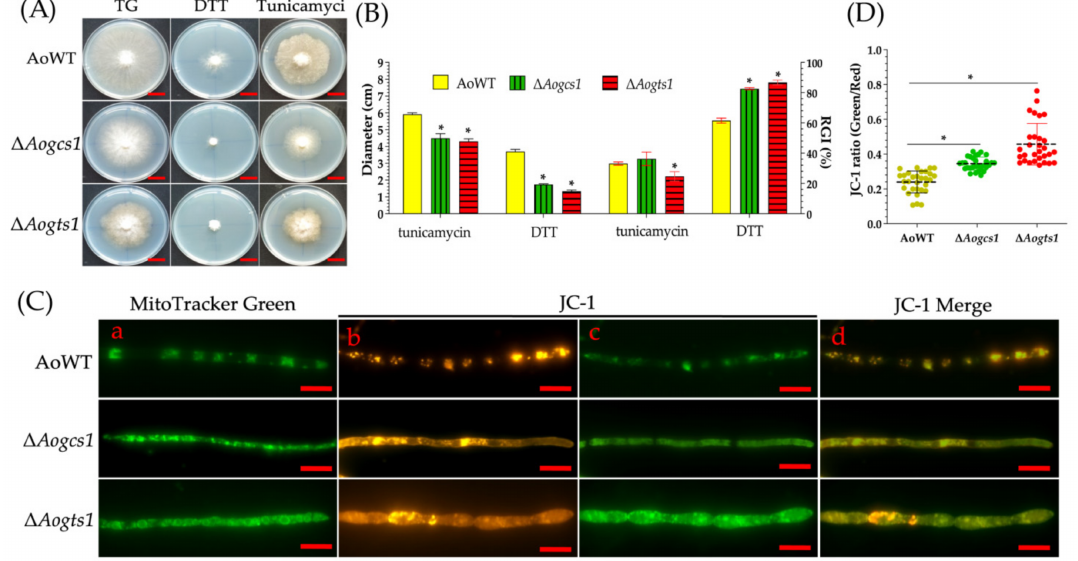
Figure 7. Influence of AoGcs1 and AoGts1 on the endoplasmic reticulum stress response and on mitochondrial morphology and activity. ( A ) Colony morphologies of WT and mutant strains cultured in the presence of DTT and tunicamycin at a concentration of 10 mM. Bar = 2 cm. ( B ) Colony diameters and the relative growth inhibition (RGI) values of the WT and mutant strains cultured with 10 mM DTT and 10 mM tunicamycin. ( C ) Comparison of mycelial mitochondrial morphology